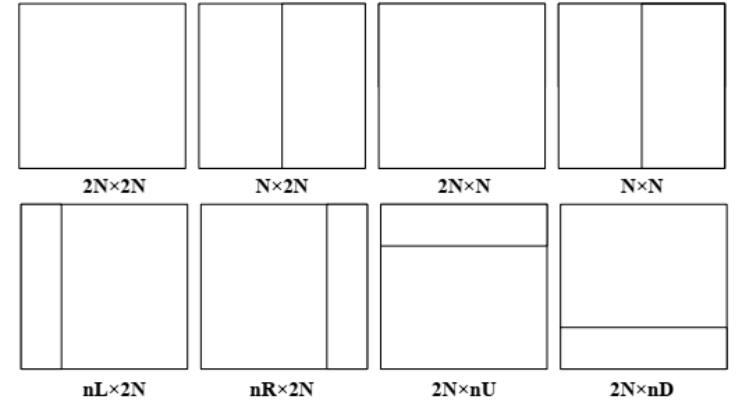
Figure 1. Illustration of block partitions in HEVC inter coding .